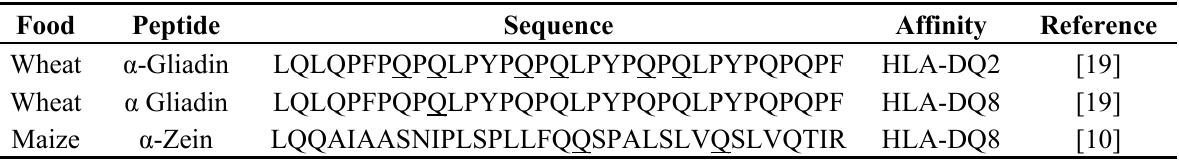
Table 2. Theoretical peptide sequences that bind to HLA-DQ2/DQ8 molecules. After an electronegative residue that binds to p4 and 6 in HLA-DQ2 and p1 and 9 in